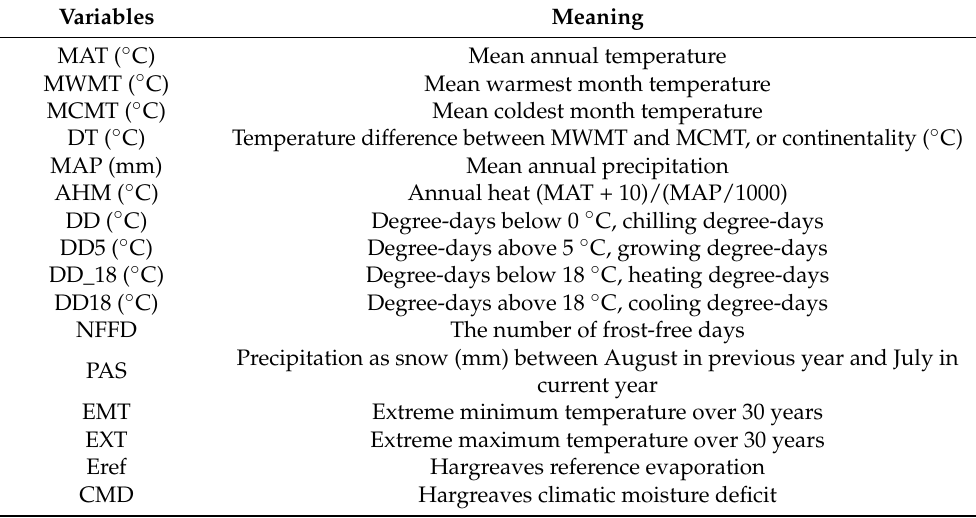
Table 1. Definition of climate variables.